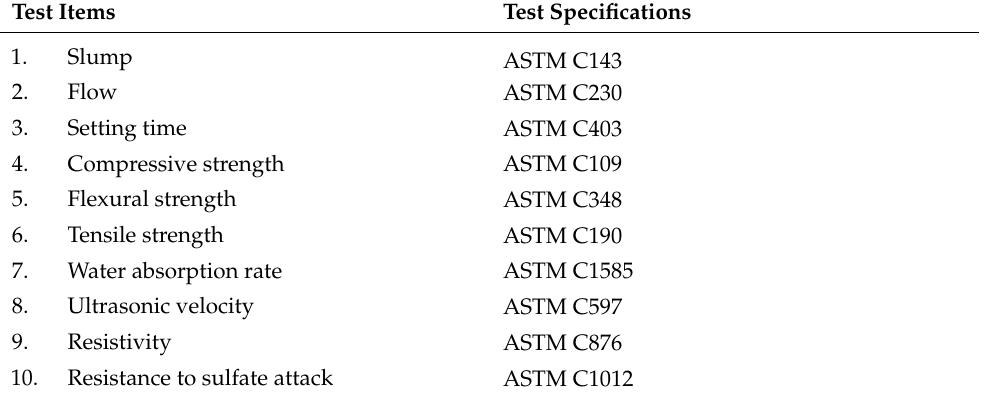
Table 3. The test methods and